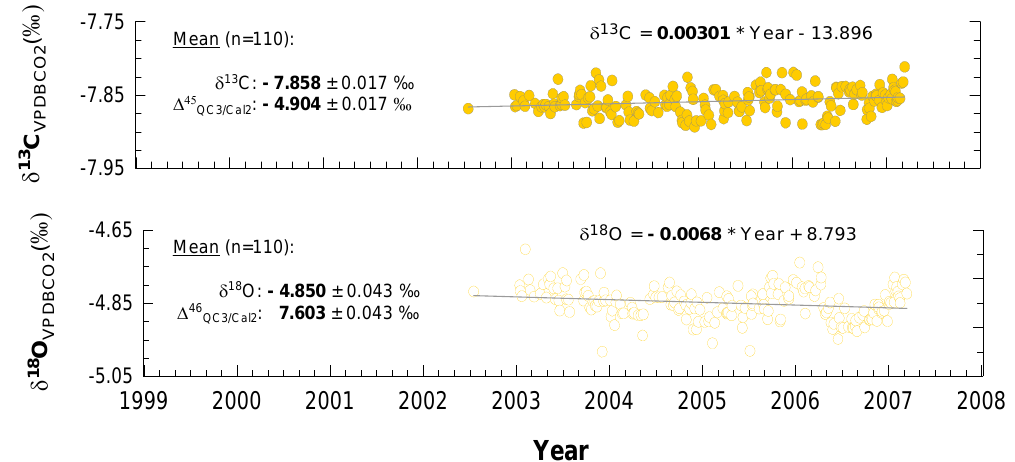
Fig. 4. Isotopic measurements of QC3 from 2003 to 2008 (QC3 is an aluminum high-pressure air-CO 2 tank that was filled with dry air at 4. Isotopic measurements of QC3 from 2003 to 2008 (QC3 is an Aluminum high 922 Alert in Sept. 2000). Top panel is for δ 13 C and the bottom panel for δ 18 O (the range of “Year” in the linear relationship: > 2002 and < 2008). pressure air-CO tank, which was filled with dry air at Alert in Sept. 2000). Top panel is for 923 2  13 C and the bottom panel for  18 O (the range of “Year” in the linear relationship: > 2002 924 and < 2008). 925